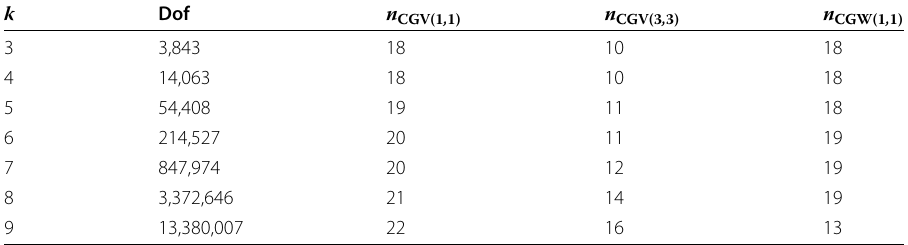
Table 3 Measured iteration numbers n CG for the preconditioned CG method attained for the model problem (19) on the configuration depicted in Fig. 4 using a single element overlap